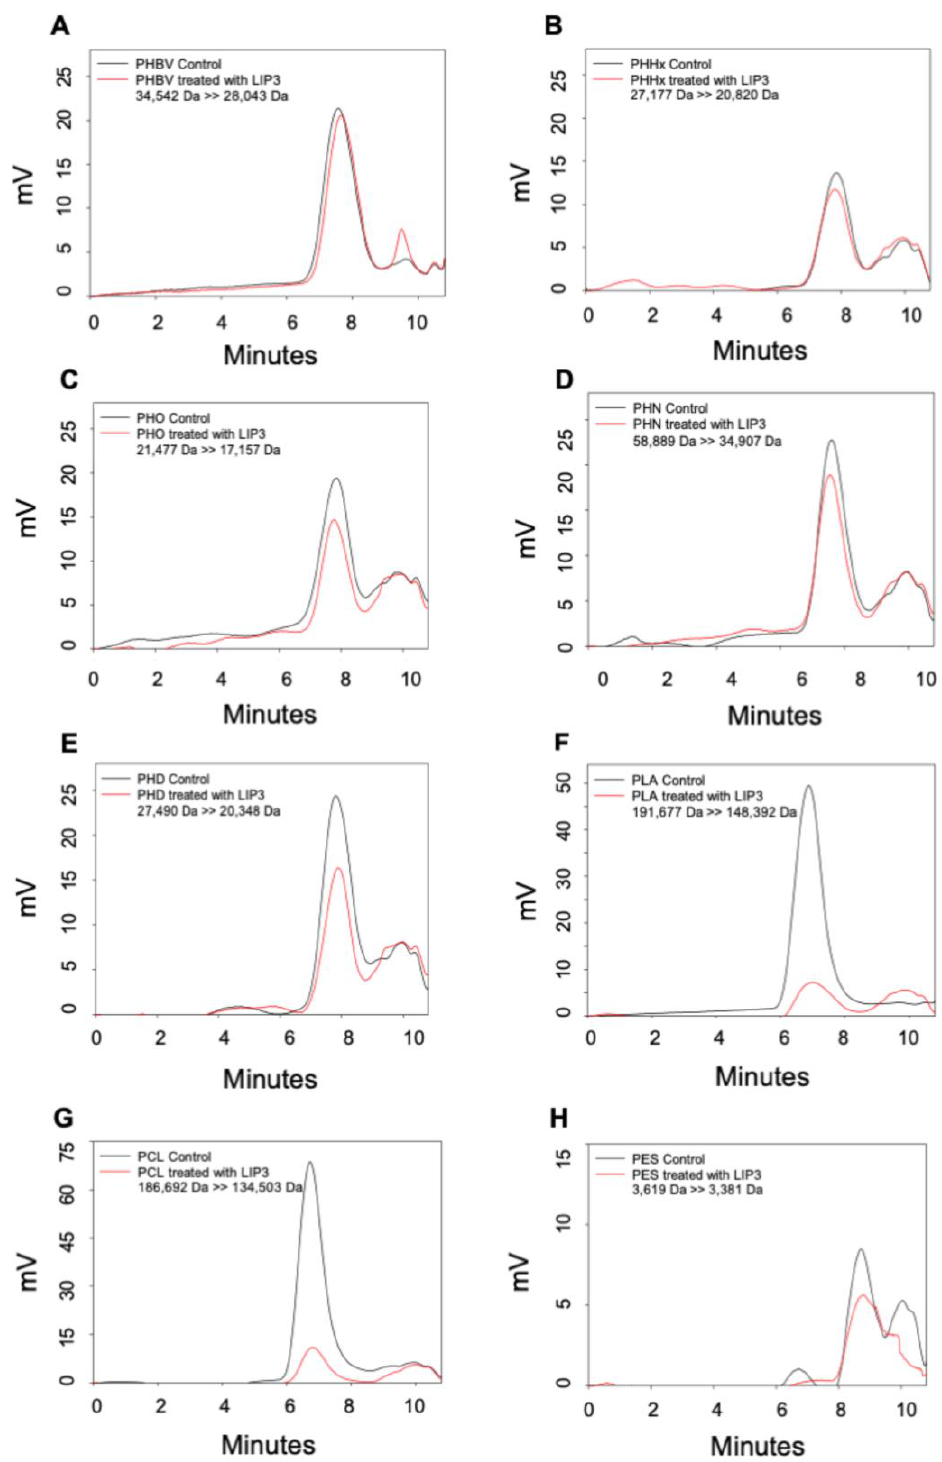
Figure 8. Gel Permeation Chromatography (GPC) analyses of LIP3. The overlay of chromatograms of different polymer substrates before (control = black line) and after LIP3 treatment (red line). ( A ) PHBV; ( B ) PHHx; ( C ) PHO; ( D ) PHN; ( E ) PHD; ( F ) PLA; ( G ) PCL; and ( H ) PES. Numbers indicate the change in polymer molecular weight before and after treatment. mV, the HPLC Refractive Index Detector records the signa intensity in millivolts.